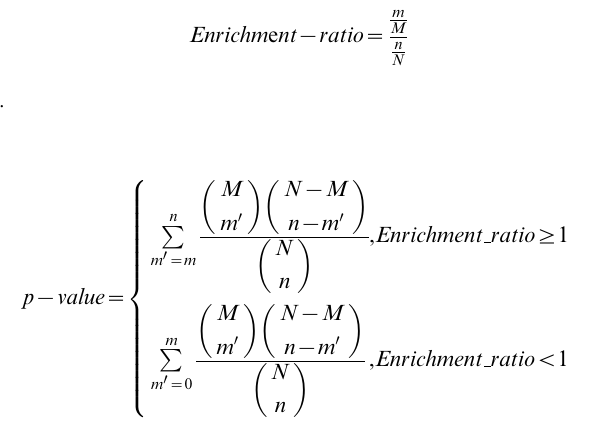
Table S6 The putative target genes of 5 abundant novel miRNAs. Table S7 The top 10 most enriched GO terms of biological processes, molecular functions and cellular components in predicted targets of 5 abundant novel miRNAs. Table S8 The most enriched pathways in predicted miRNA targets for top abundant novel miRNAs (p , 0.05, E-ratio . 2). Table S9 The detail description of the miRNA-mRNA pairs. Table S10 piRNAs with . 1000 reads map uniquely using Blat within TDRG1. Table S11 piRNAs with . 500 reads map uniquely within CYP19A1. Table S12 All miRNAs with greater than 10% of reads arising from possible editing events. Table S13 Primers used for the quantification of